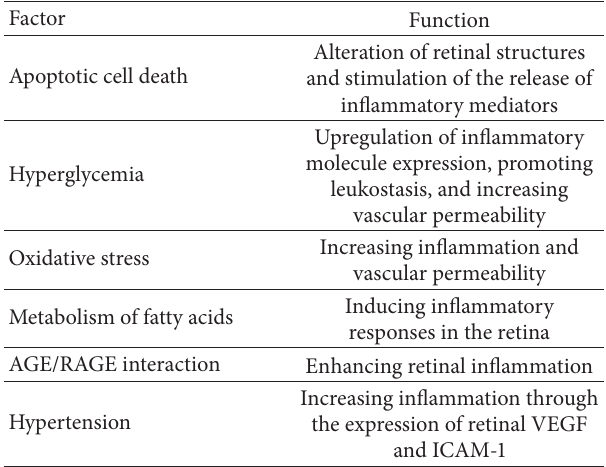
Table 1: Mechanisms influencing inflammatory responses in dia-